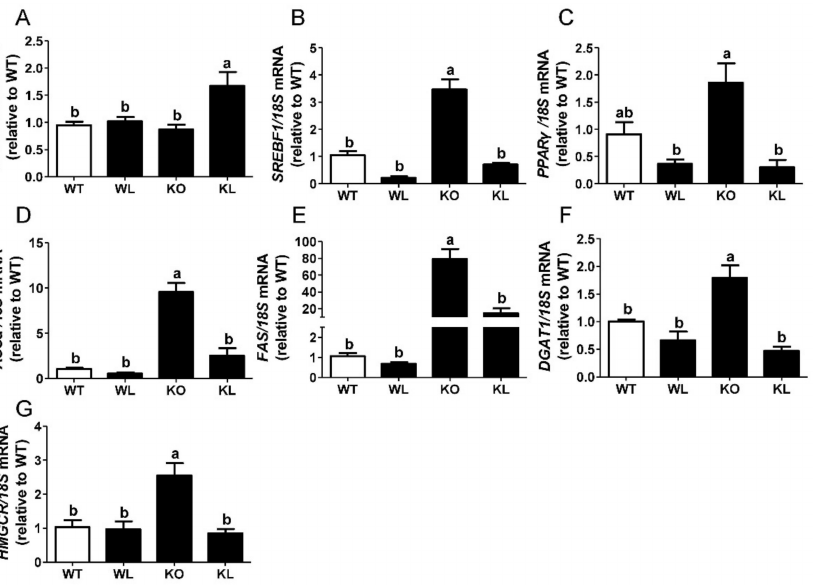
Figure 5. LWE decreased hepatic lipogenic gene expression in the liver of Lepr − / − rats. ( A ) SIRT6 ; ( B ) SREBF1 ; ( C ) PPAR γ ; ( D ) ACC α ; ( E ) FAS ; ( F ) DGAT1 ; ( G ) HMGCR . Values are means ± SEM (n = 4–6). Columns with different letters are significantly different ( p < 0.05).